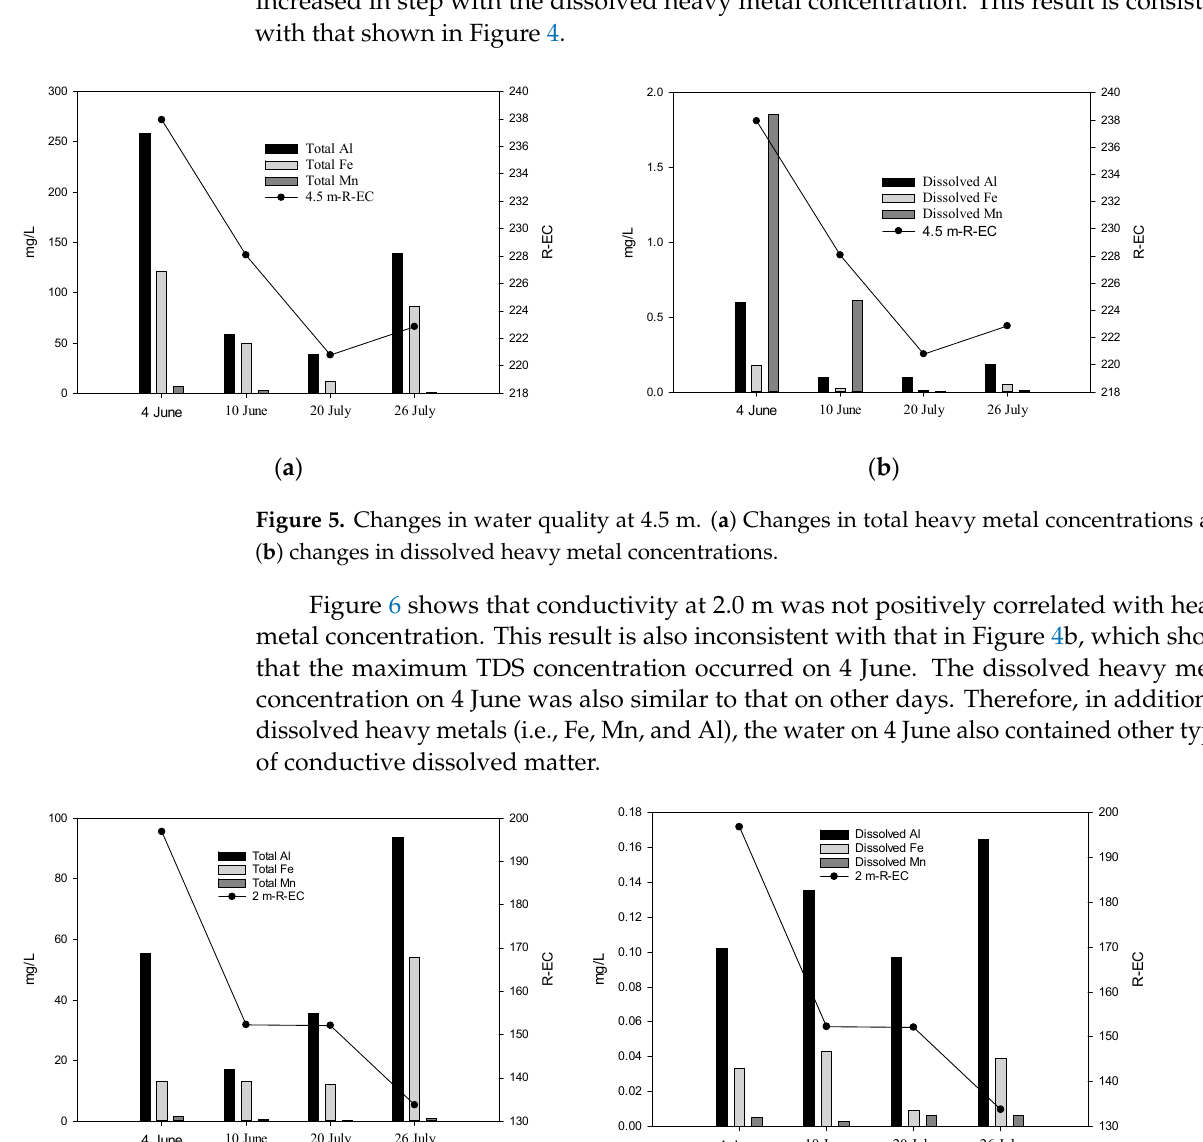
Figure 4. Changes in suspended solids (SS), total dissolved solids (TDS), and R-EC at depths of ( a ) 4.5 m and ( b ) 2.0 m.